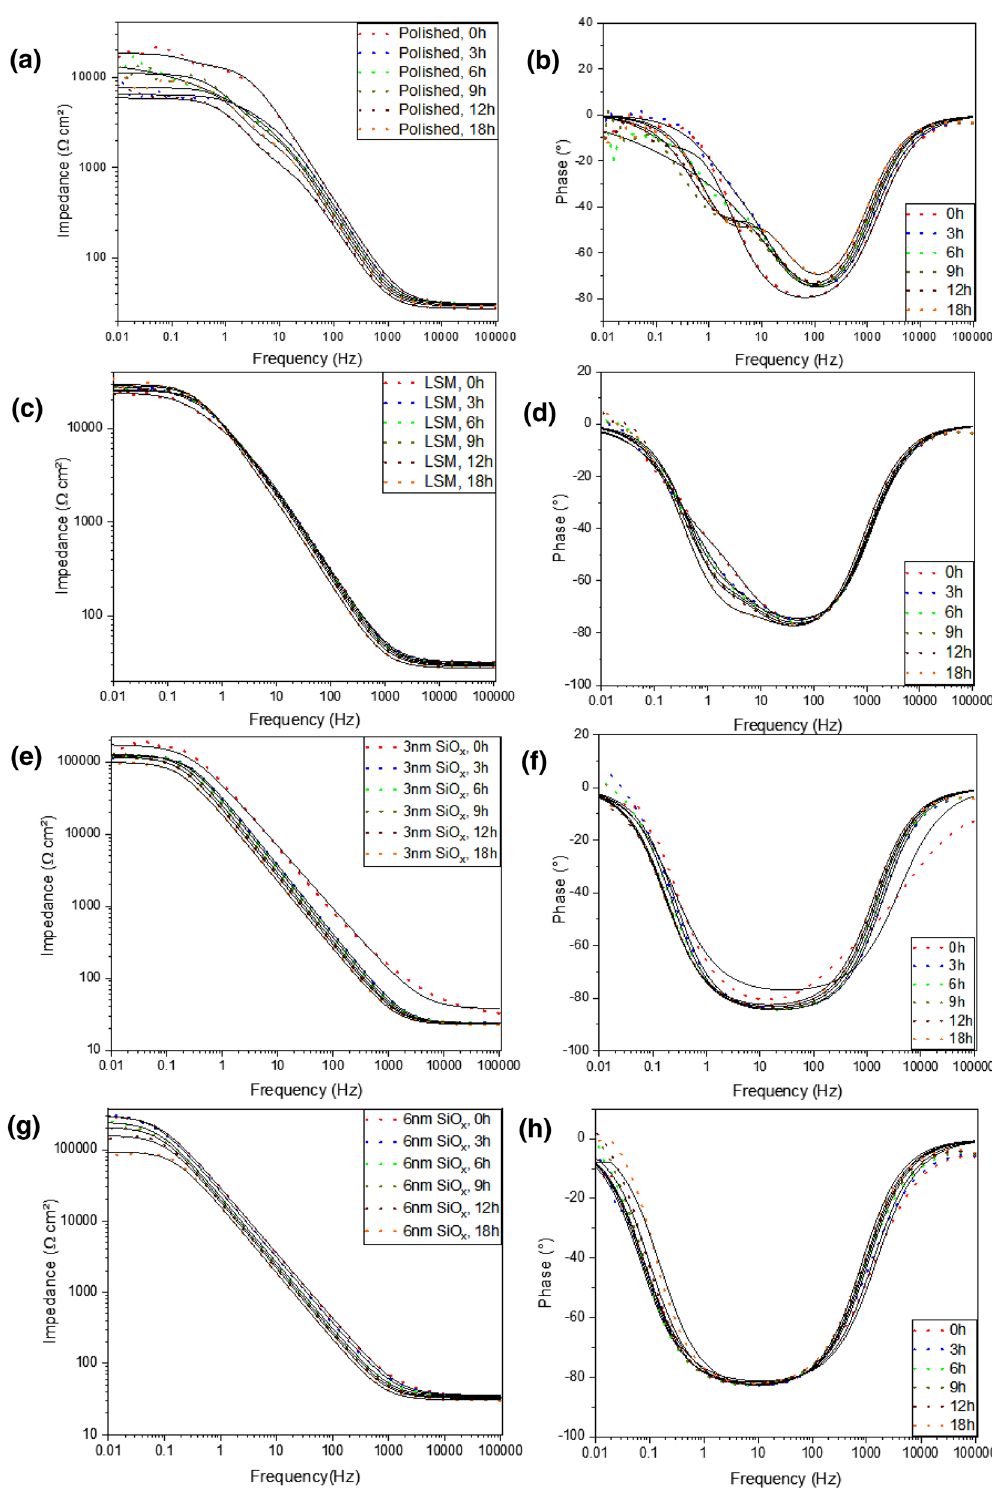
d Phase plots LSM-7075, e 3 nm SiO deposited film Impedance, x and f Phase plots 3 nm SiO deposited film, g 6 nm deposited film x Impedance and h Phase plots 6 nm deposited